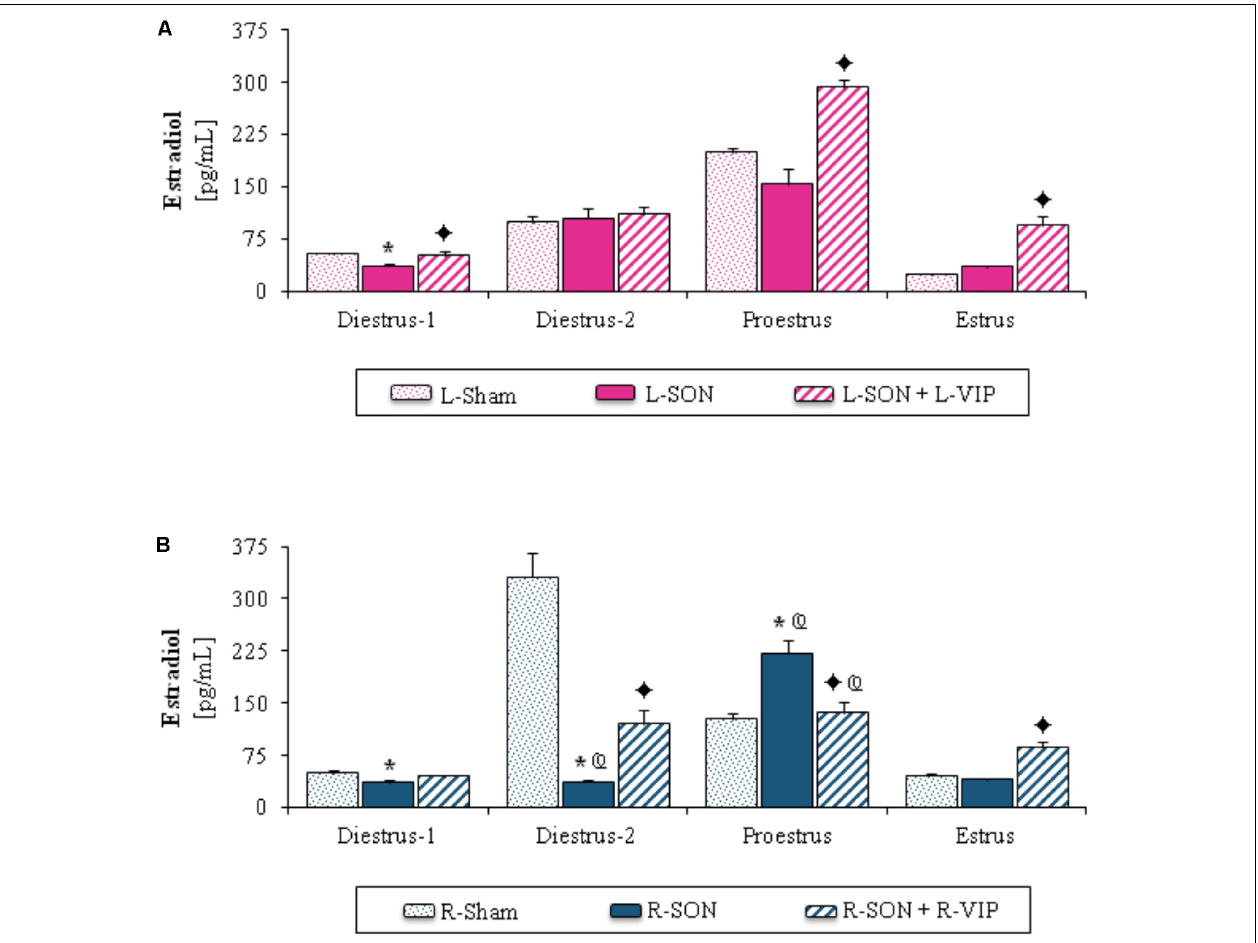
FIGURE 3 | Mean ± SEM of estradiol (pg/mL) serum levels in animals submitted to left (A) or right (B) sham surgery (L-Sham or R-Sham), or the left or right sectioning of the superior ovarian nerve (L-SON or R-SON) with or without subsequent treatment with VIP into the left or right denervated ovary (L-VIP or R-VIP). Animals were sacrificed 1 h after surgery. ∗ p < 0.05 vs. its respective L-Sham or R-Sham group; (cid:70) p < 0.05 vs. its respective L-SON or R-SON group; p < 0.05 vs. group with the same treatment of the left side (Student’s t